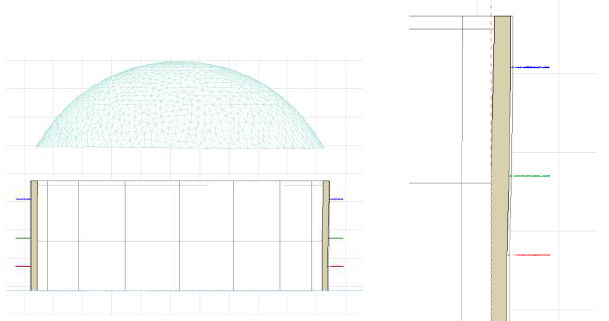
Figure 13. Section through dome and drum walls automatically created from survey data with procedural rules. Section shows true condition of wall which contains